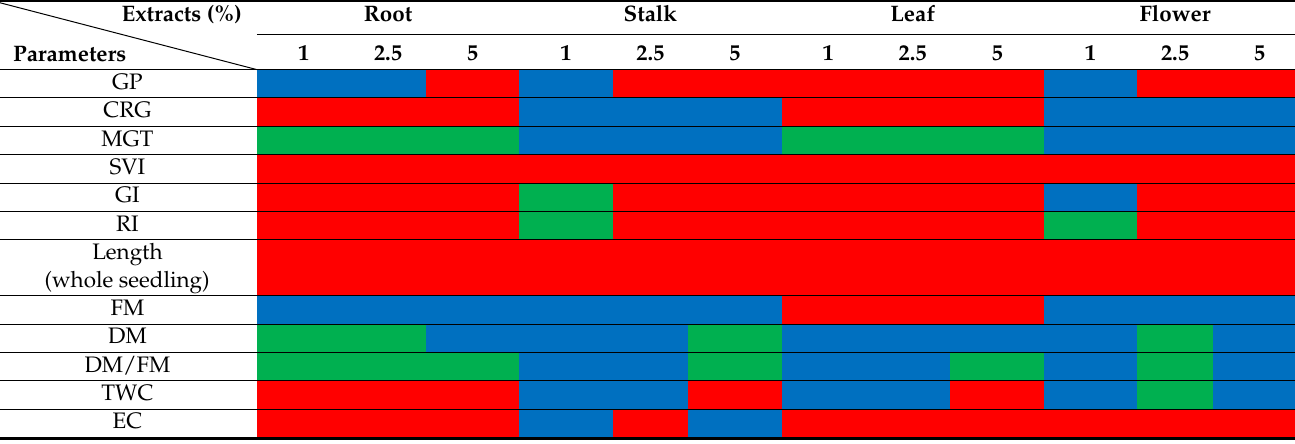
Table 3. Comparison of the studied germination and growth parameters of Festuca rubra L. seedlings grown on the aqueous extracts from the organs of Rosa blanda Aiton with different percentage concentrations (1%, 2.5%, 5%). ParametersExtracts (%) Root Stalk Leaf Flower 1 2.5